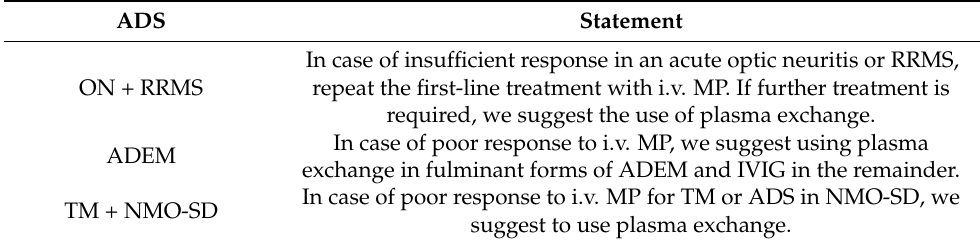
Table 4. Choice of second-line